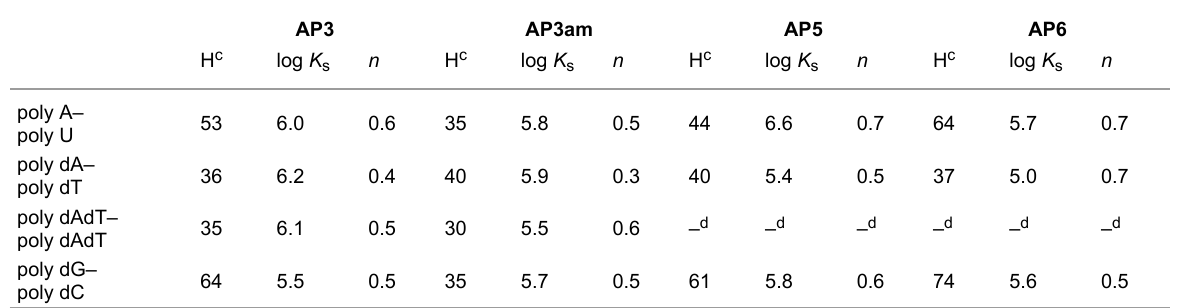
Table 2: Binding constants (log K s ) a and ratios n b ([bound compound]/[polynucleotide phosphate]) calculated from the UV–vis titrations of AP3 , AP3am, AP5 and AP6 with ds-polynucleotides at pH 7.0 (buffer sodium cacodylate, I = 0.05 mol dm − 3 ). AP3